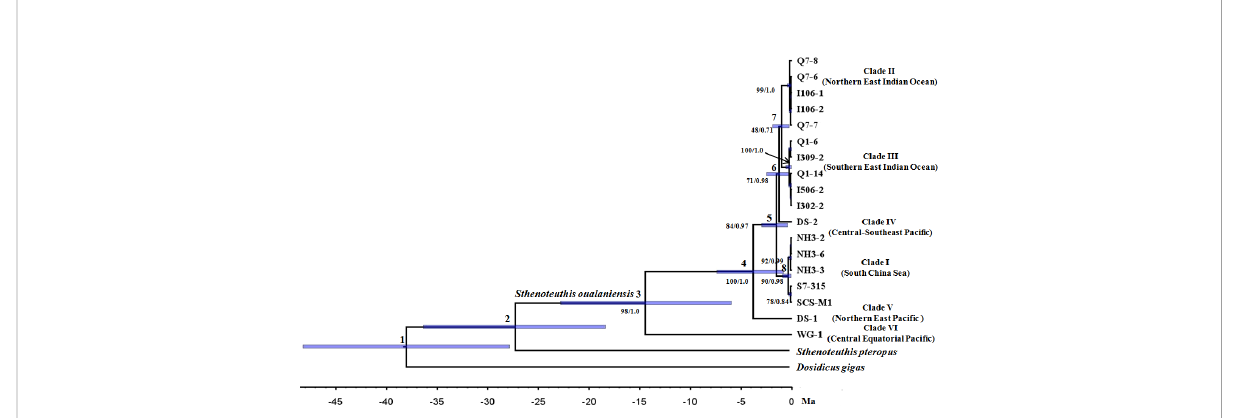
FIGURE 2 Bayesian relaxed clock cladogram based on concatenated mitochondrial cytochrome c oxidase subunit 1 (COI) and cytochrome b ( Cyt b ) sequences. Numbers above branches show ancestral nodes, and numbers below branches indicate nodal support values measured as bootstrap values (BP) and posterior probability (PP) inferred by maximum likelihood (ML) and Bayesian inference (BI) methodologies,